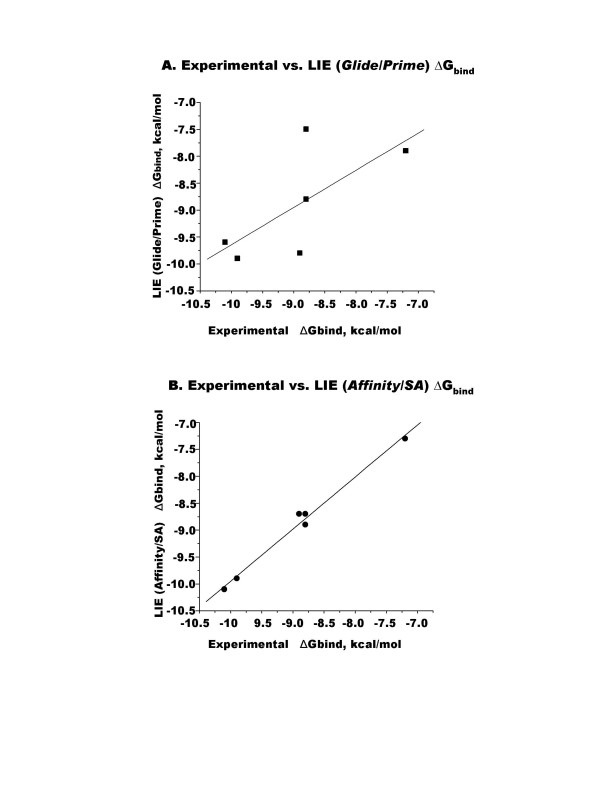
Binding energy correlation between experimental ΔGbind and LIE (Glide/Prime) ΔGbind (A) or LIE (Affinity/SA) ΔGbind (B).